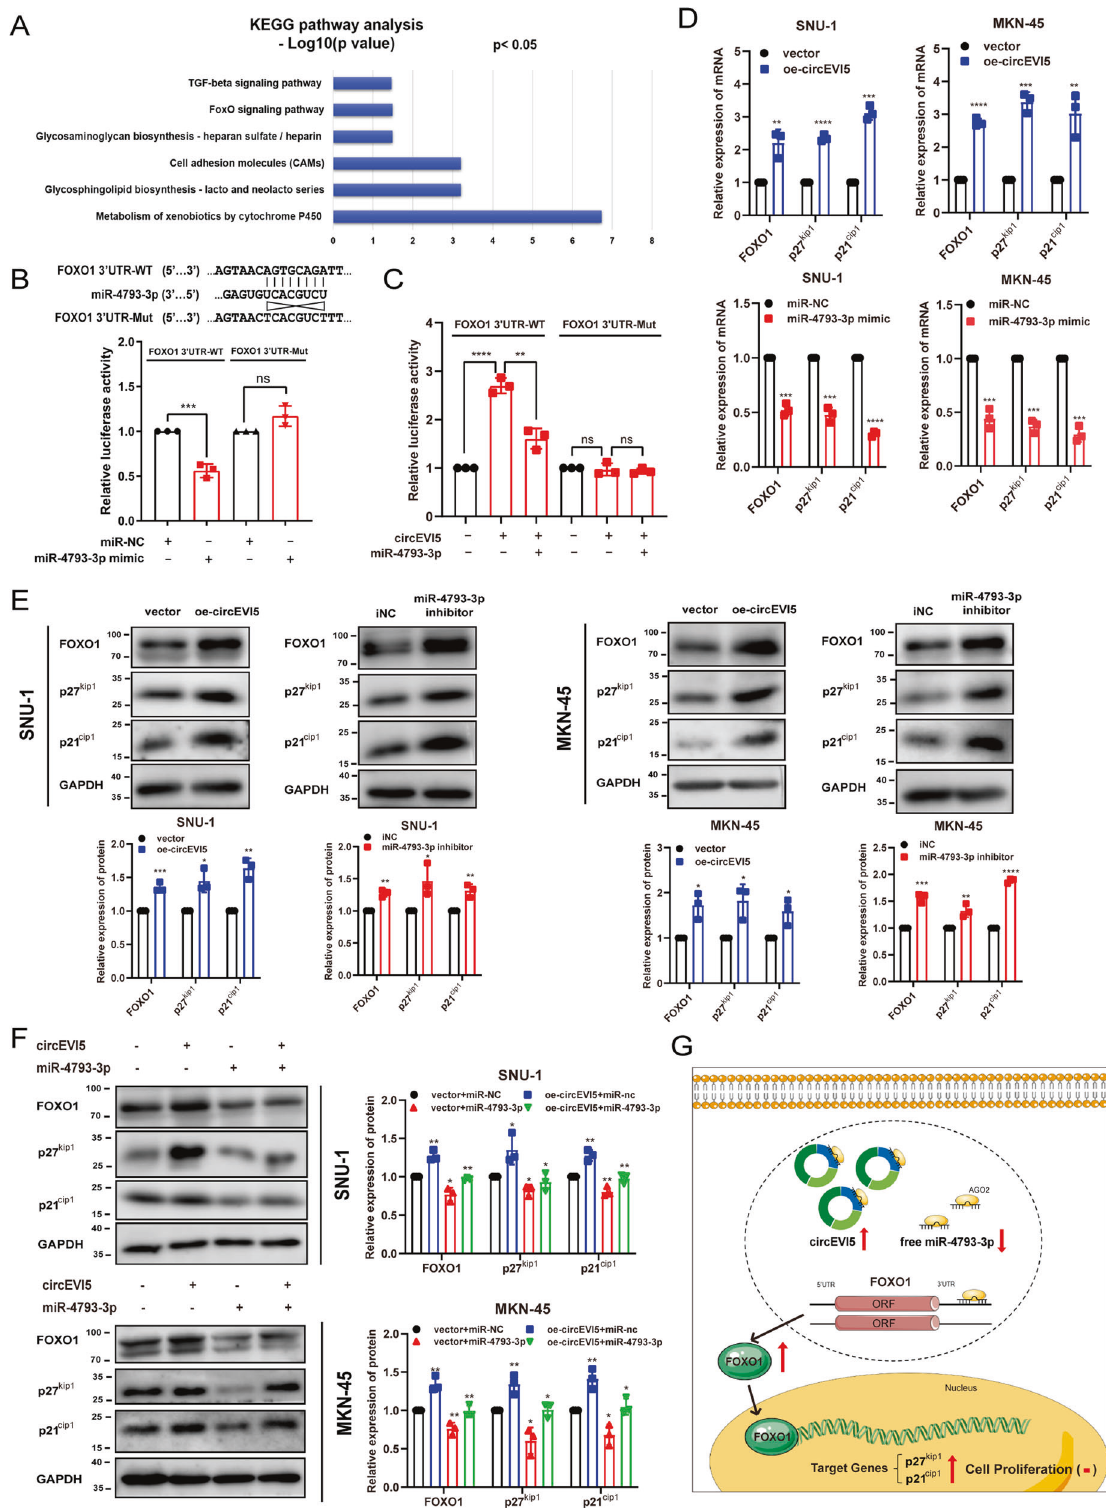
lines. circEVI5 markedly inhibited GC cell proliferation by competitively binding miR-4793-3p as a ceRNA to upregulate FOXO1. Our fi ndings provide a novel potential biomarker for prognosis and a promising treatment target in gastric